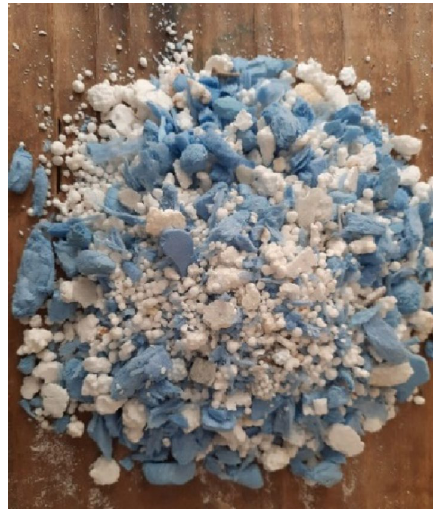
Fig. 3 Expanded polystyrene (EP) aggregates